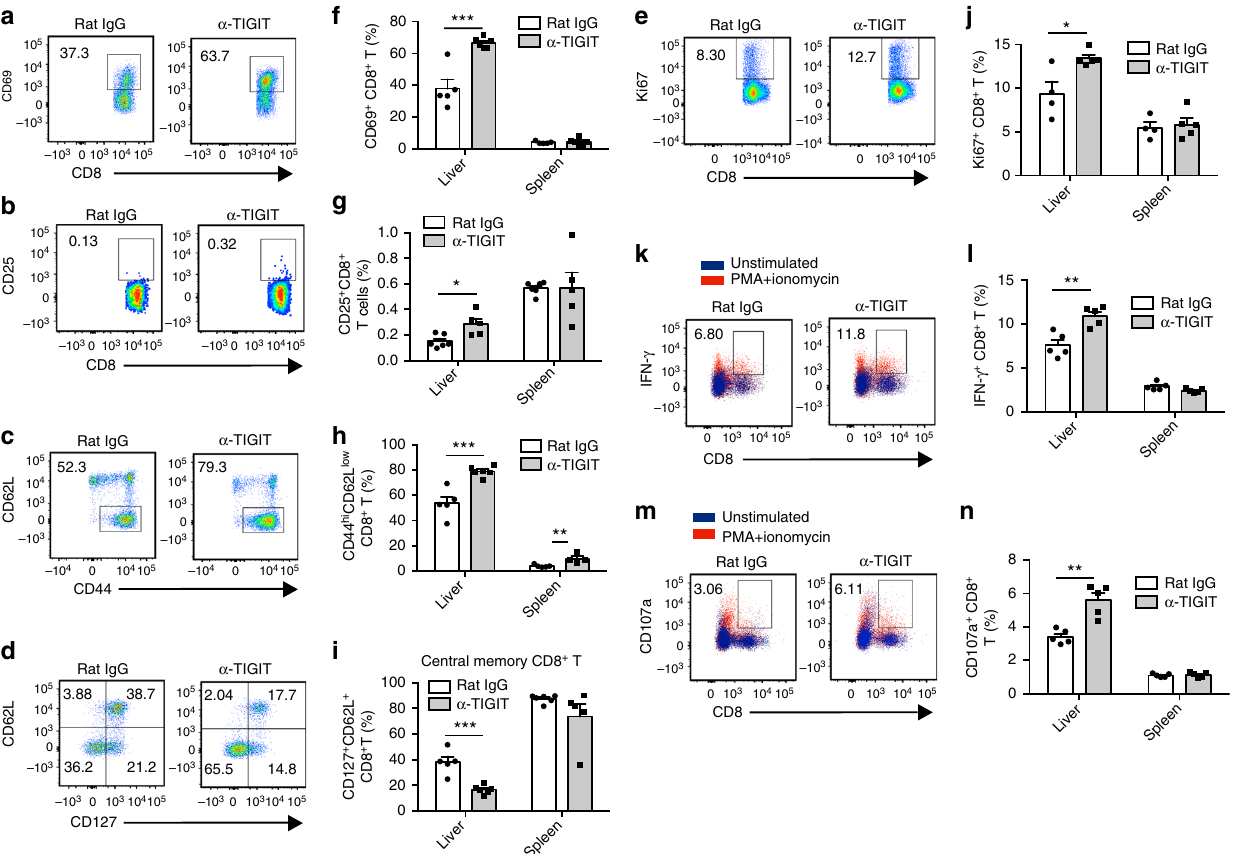
Fig. 6 Functional tolerance of hepatic CD8 + T cells is broken after TIGIT blockade in HBs-tg mice. a – n HBs-tg mice were treated with rat IgG or α -TIGIT mAb for 3 months. a – e Representative fl ow cytometry graphs showing hepatic CD69 + CD8 + T cells ( a ), CD25 + CD8 + T cells ( b ), CD44 hi CD62L low CD8 + T cells ( c ), CD127 + CD62L + CD8 + T cells ( d ), and Ki67 + CD8 + T cells ( e ) in rat IgG or α -TIGIT-treated HBs-tg mice. f – j Percentages of hepatic and splenic CD69 + CD8 + T cells ( f ), CD25 + CD8 + T cells ( g ), CD44 hi CD62L low CD8 + T cells ( h ), CD127 + CD62L + CD8 + T cells ( i ), and Ki67 + CD8 + T cells ( j ) in rat IgG or α -TIGIT-treated HBs-tg mice ( n = 4 – 6 in each group). k – n Expression of CD107a ( k , l ) and intracellular IFN- γ ( m , n ) by hepatic and splenic CD8 + T cells of mice after ex vivo stimulation with PMA and ionomycin ( n = 5 in each group). Statistically signi fi cant differences between the groups are presented as the mean ± SEM. * P <0.05; ** P < 0.01; and *** P < 0.001 (two-tailed unpaired Student ’ s t -test). Data are representative of at least